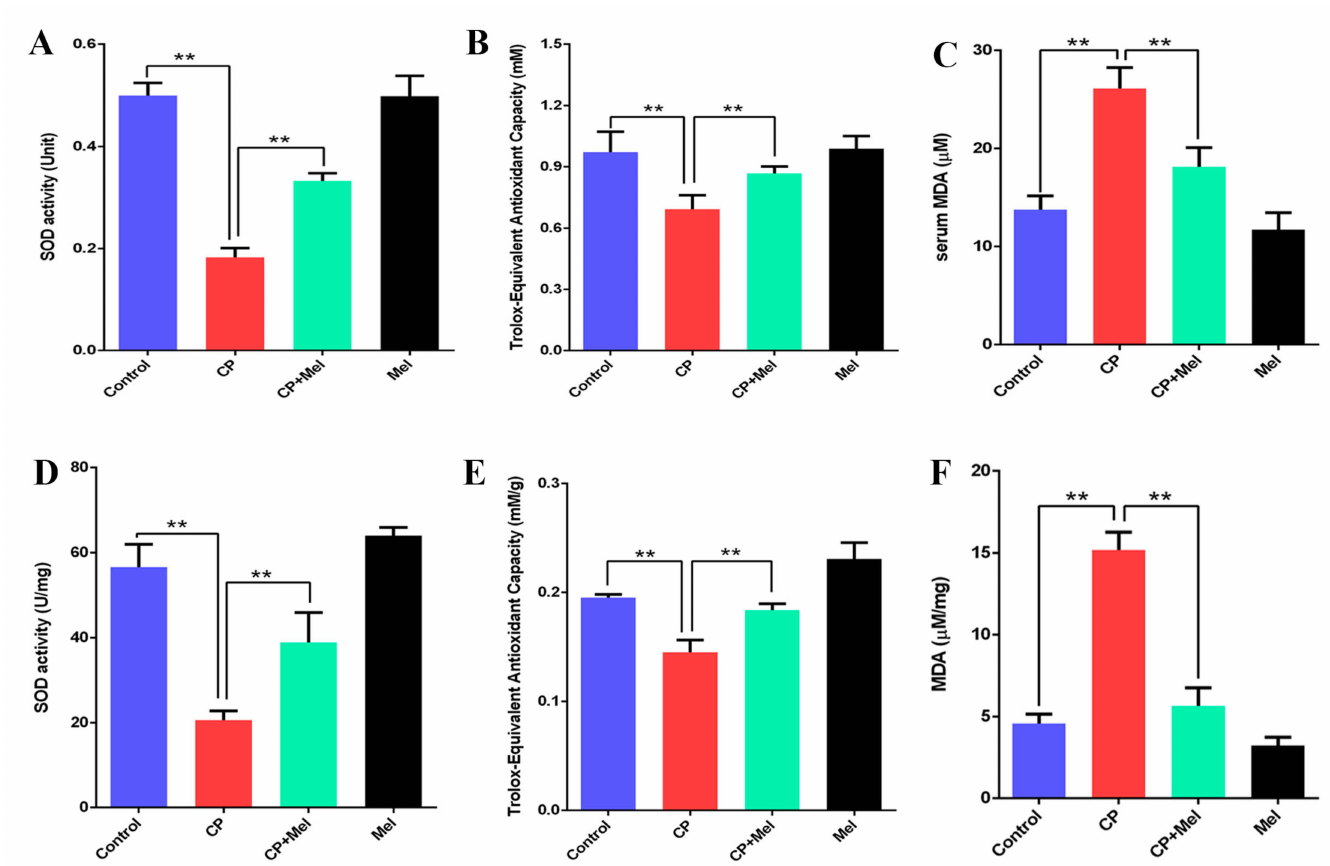
Figure 6. Melatonin can attenuate oxidative stress caused by cisplatin in mouse sera and testes. ( A ) Detection of serum SOD activity in mice. ( B ) Detection of serum total antioxidant capacity in mice. ( C ) Detection of serum MDA in mice. ( D ) Detection of SOD activity in mouse testes. ( E ) Detection of the total antioxidant capacity in mouse testes. ( F ) Detection of MDA in mouse testes. CP, cisplatin. CP + Mel, cisplatin + melatonin. Mel, melatonin. Data are presented as the mean ± SEM. ( N = 8 per group). ** p < 0.01 compared with controls or CP